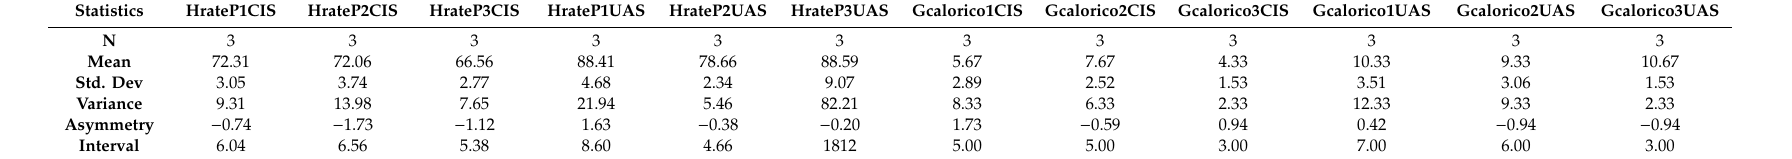
Table 1. Descriptive analysis of heart rate (HR) and caloric expenditure variables for the pilot study.